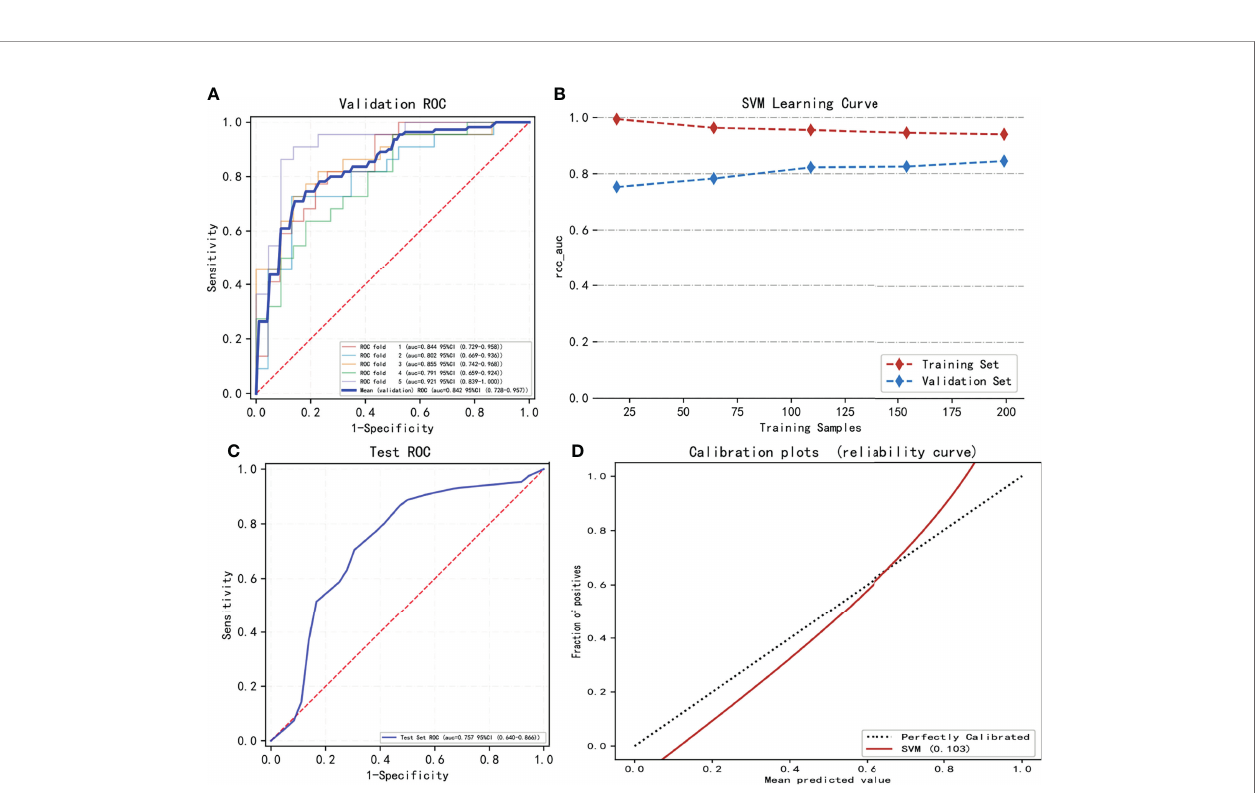
FIGURE 4 | The model training and testing process. (A) The area under the curve (AUC) values of LASSO_SVM in internal validation [5-fold cross-validation (cv)]. (B) The variation trend of the model ’ s AUC value with the increasing sample size. (C) The AUC value of LASSO_SVM in external validation (test set). (D) Model ’ s calibration curve shows good fi tting effect.